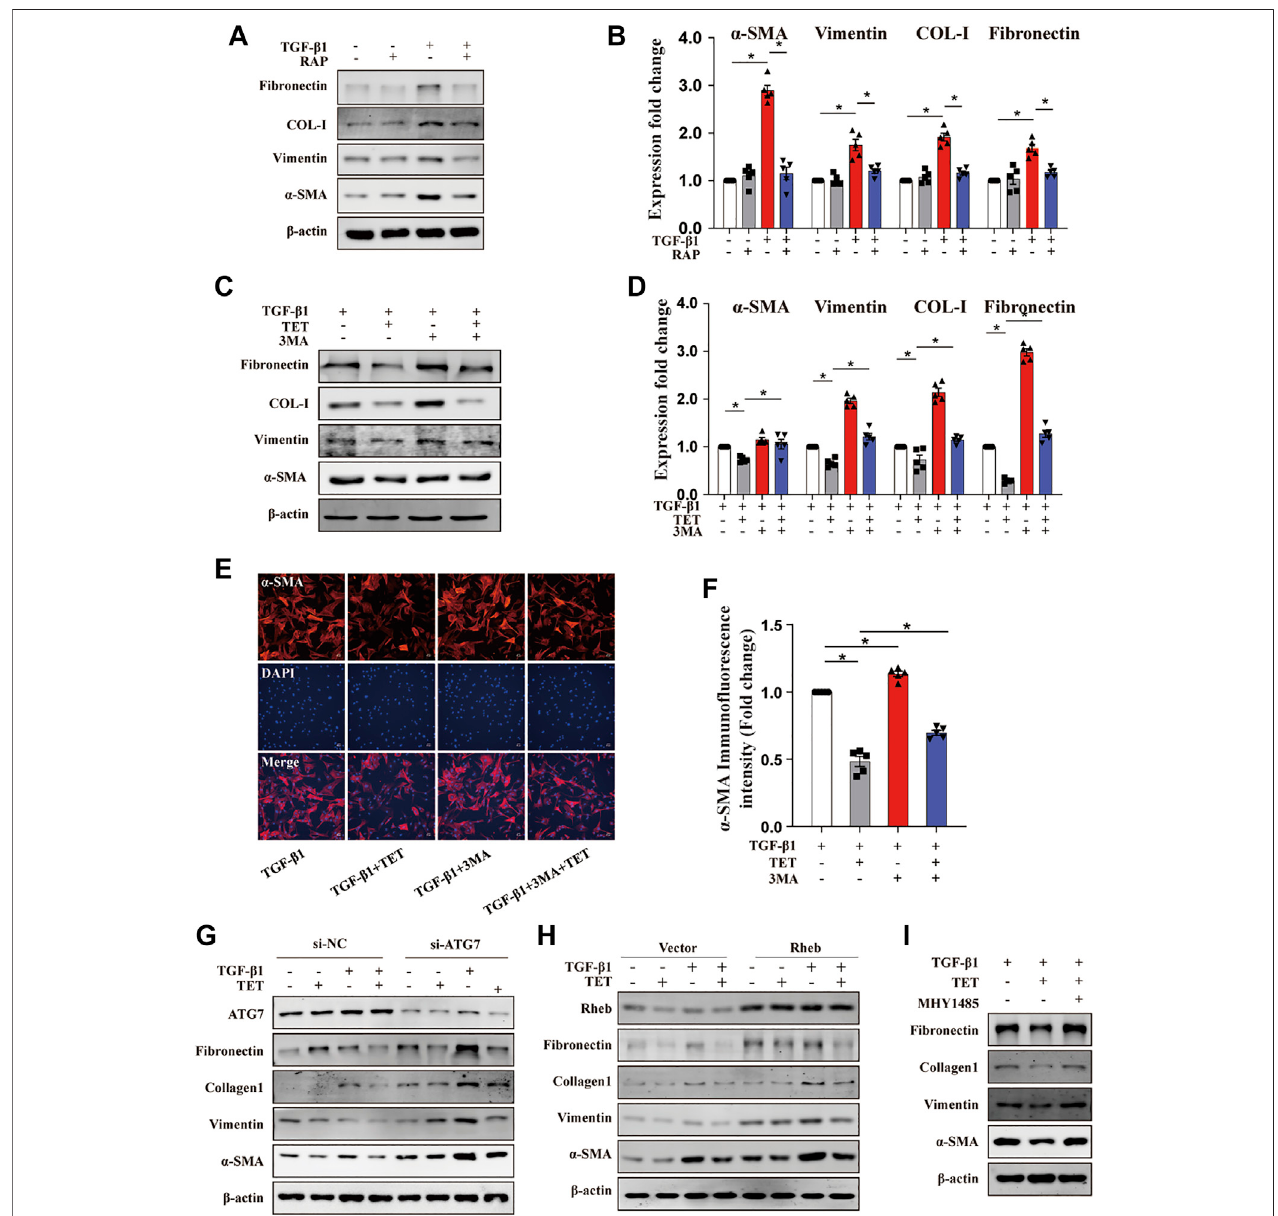
FIGURE 7 | TET improves pulmonary fi brosis by activating autophagy through Rheb/mTOR in MLFs. Primary MLFs were treated with TGF- β 1 (0 or 10 ng/ml) for 24 h in the presence/absence of TET (4 μ M), 3 MA (500 nM), RAP (50 nM), or MHY1485 (a small molecule mTOR activator, 5 μ M). (A,B) Representative immunoblot analysis (A) and quantitative analysis (B) showed the expression of fi brosis-associated proteins. (C,D) The effect of autophagy on TGF- β 1-induced primary MLFs. Immunoblot (C) and quantitative analysis (D) showed the expression of ECM deposition, myo fi broblasts transdifferentiation markers. (E,F) Confocal microscopy images (E) and relative fl uorescence intensity of α -SMA (F) . α -SMA was visualized in green, DAPI-stained nuclei in blue. Scale bars: 50 μ m. (G) MLFs transfected with nonspeci fi cnonsilencingnegativesiRNAcontrol( si - NC )orATG7smallinterfering RNA ( si -ATG7)for48 hweretreatedwithTETandTGF- β 1.Representativeimmunoblot analysis showed the expression of fi brosis-associated proteins. (H) Cells transfected with the empty vector plasmid (vector) or Rheb overexpression plasmid (Rheb) for 48 h and then incubated with TET and TGF- β 1. Immunoblot of fi brosis-associated proteins. (I) TET-attenuated fi brosis was associated with mTOR activation. Immunoblot showed the expression of fi brosis-associated proteins. Values in bar graph are presented as means ± SEM (n (cid:2) 5). Two-way ANOVA with Tukey ’ s multiple comparison test (n (cid:2) 5). * p < 0.05.